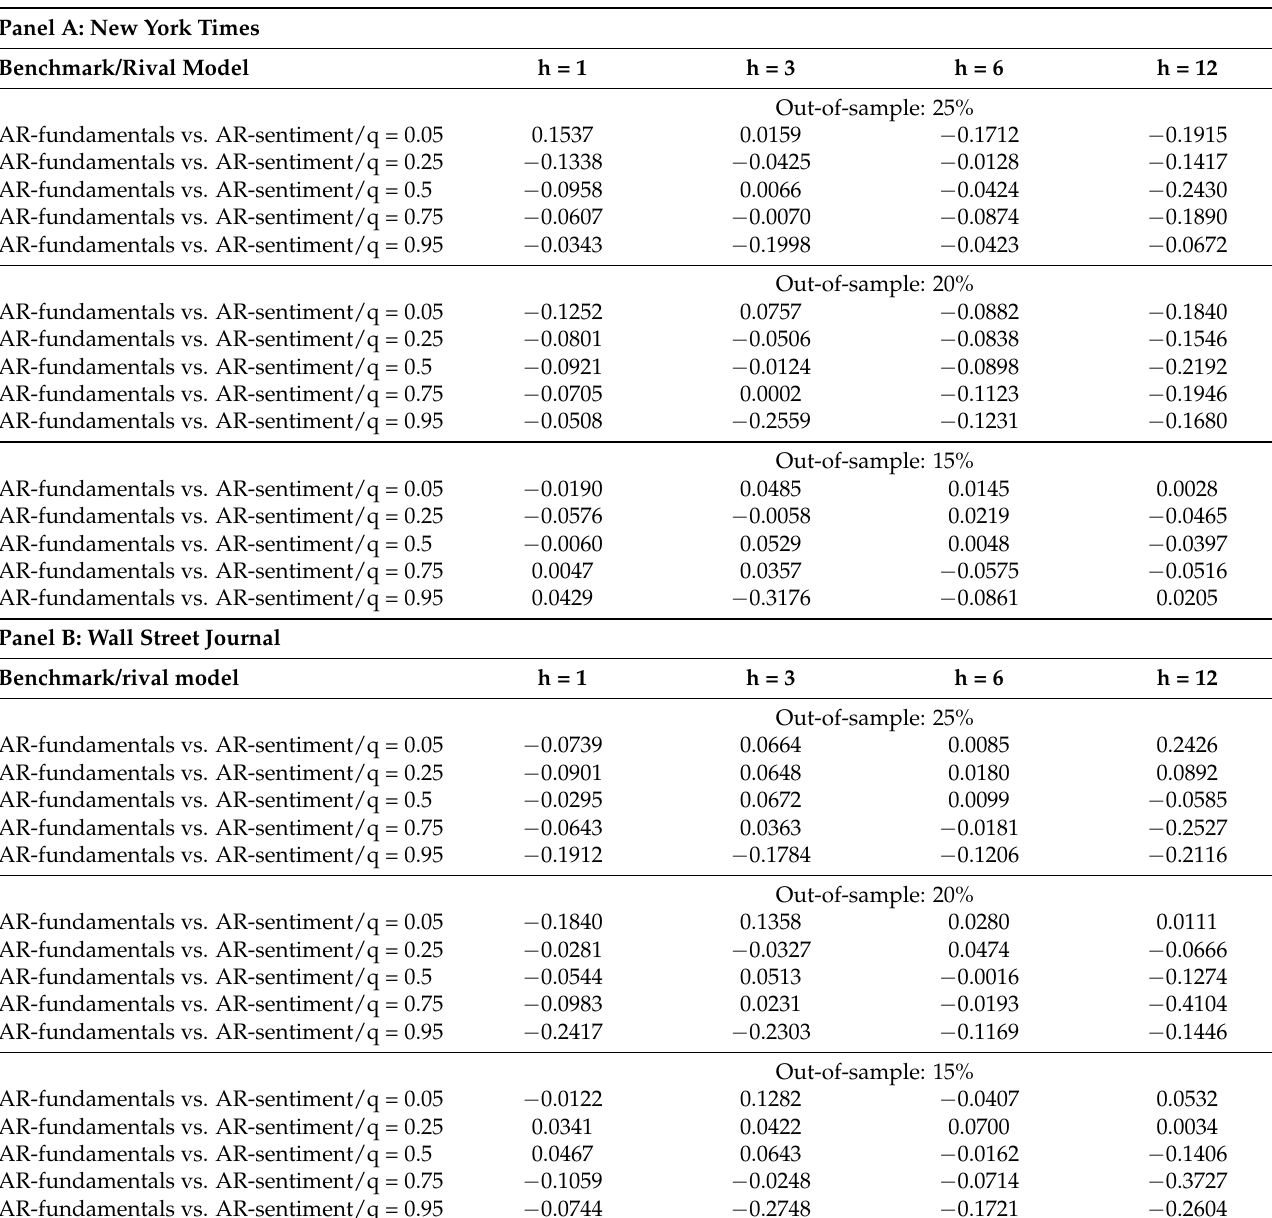
Table A6. Out-of-sample